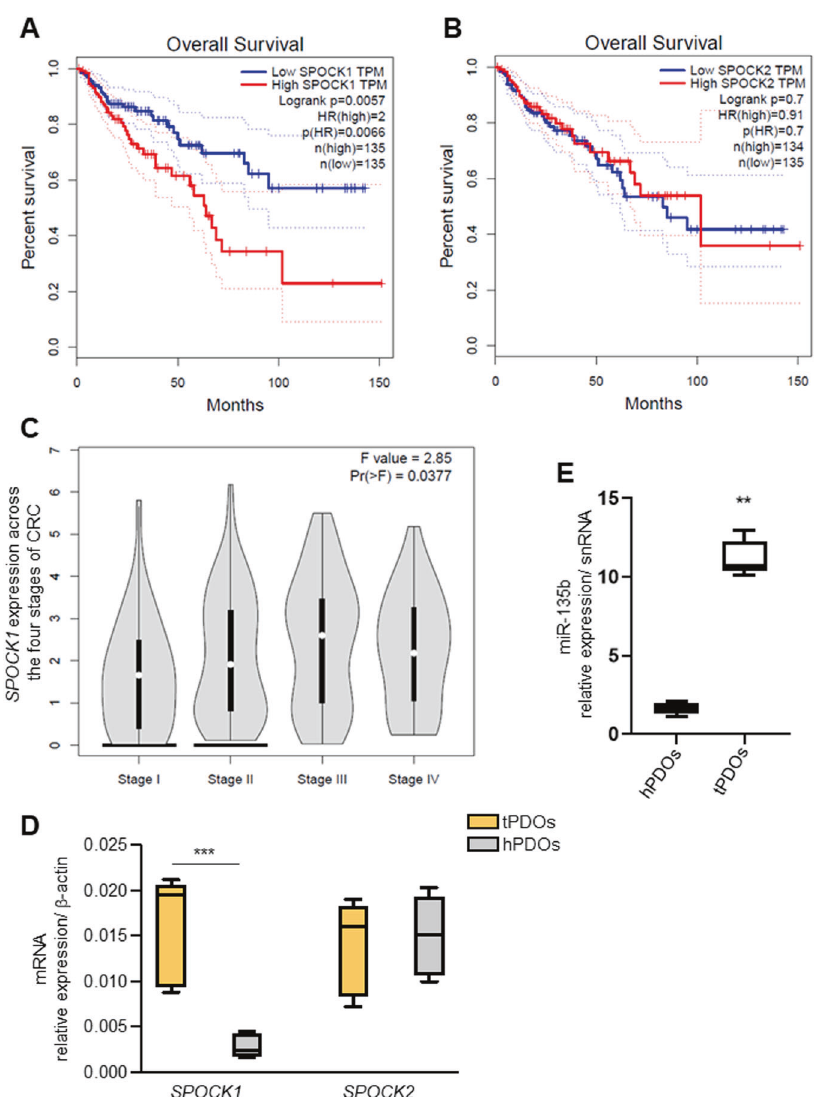
differentially expressed across the four stages of CRC, and with the highest level in advanced stages III and IV CRC. D The relative mRNA expression of SPOCK1 and SPOCK 2 detected by qRT ‐ PCR and SPOCK 1 was upregulated in CRC tPDOs compared to CRC hPDOs (*** P < 0.001).